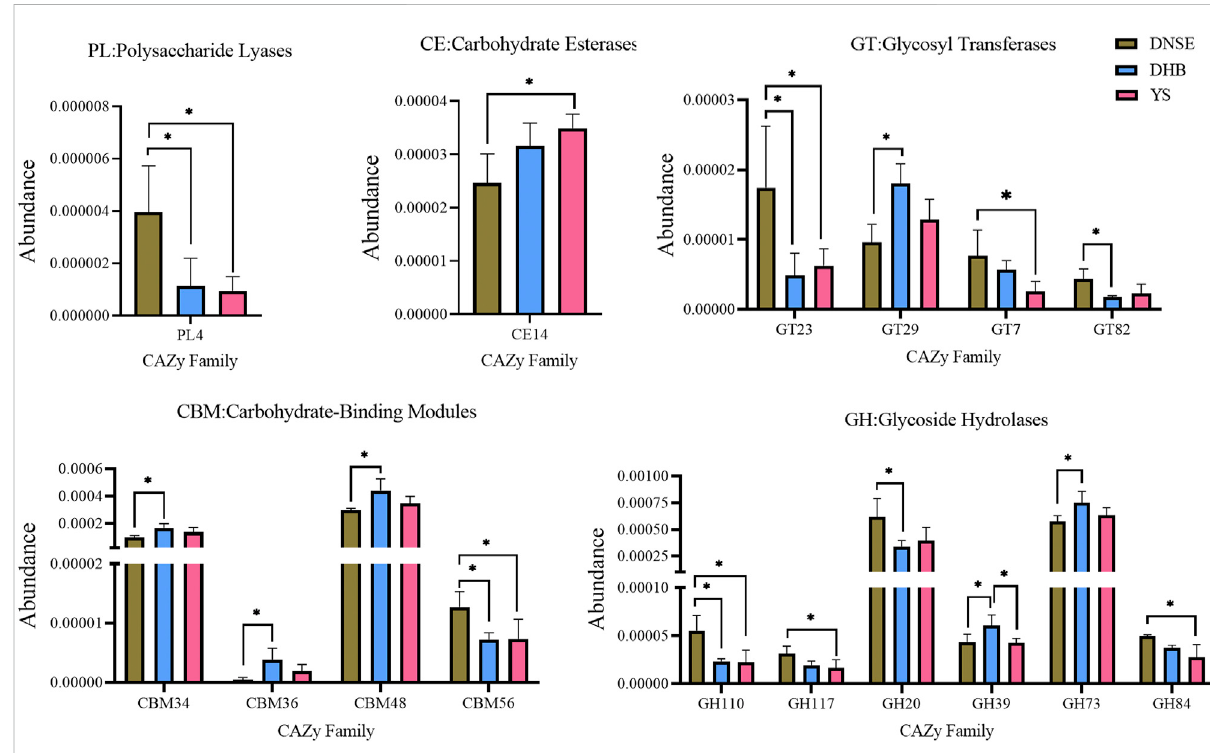
FIGURE 5 CAZy families with signi fi cant differences among three pig breeds. Error bars represents SD of three replicates, * p < 0.05.